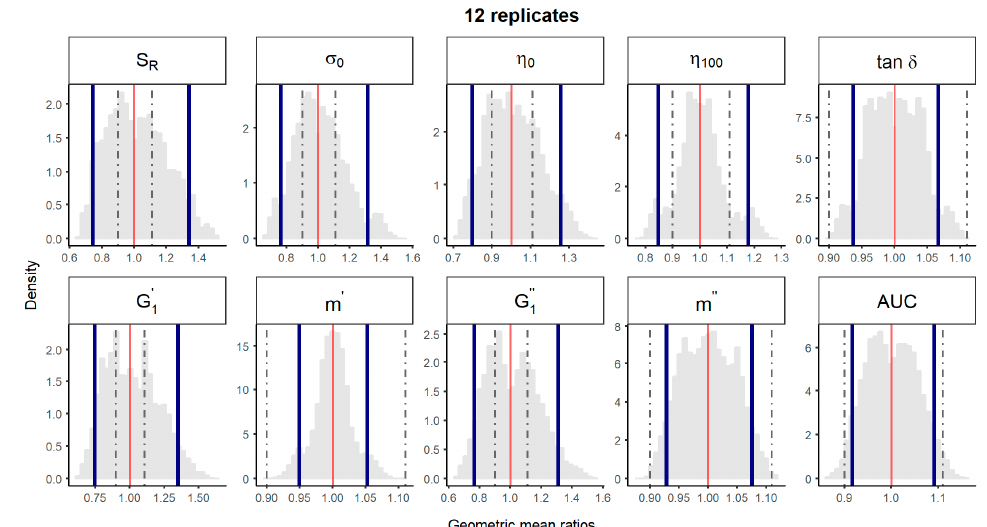
Figure 2. Bootstrap analysis of rheological parameters - 1 reference batch versus 1 reference batch. 10,000 geometric mean ratios (light grey area) resulting from the bootstrap analysis of “1 reference batch versus 1 test batch” for each rheological parameter. Data of 10 batches and 12 replicate each were used. Median (red line) and non-parametric 90% CI (blue lines) of the probability distribution. Dashed lines represent the acceptance limits for equivalence (90–111.11%) stated in the EMA guideline [4]. S R , relative thixotropic area; σ 0 , yield stress; η 0 , zero-shear viscosity; η 100 , viscosity at 100 s − 1 ; tan δ , loss tangent; G (cid:48) , 1 calculated elastic modulus; G (cid:48)(cid:48) , calculated viscous modulus; m’ and m ” are the parameters obtained 1 when fitting G’ and G”, respectively, versus frequency; AUC, area under the surface versus weight curve (spreadability).